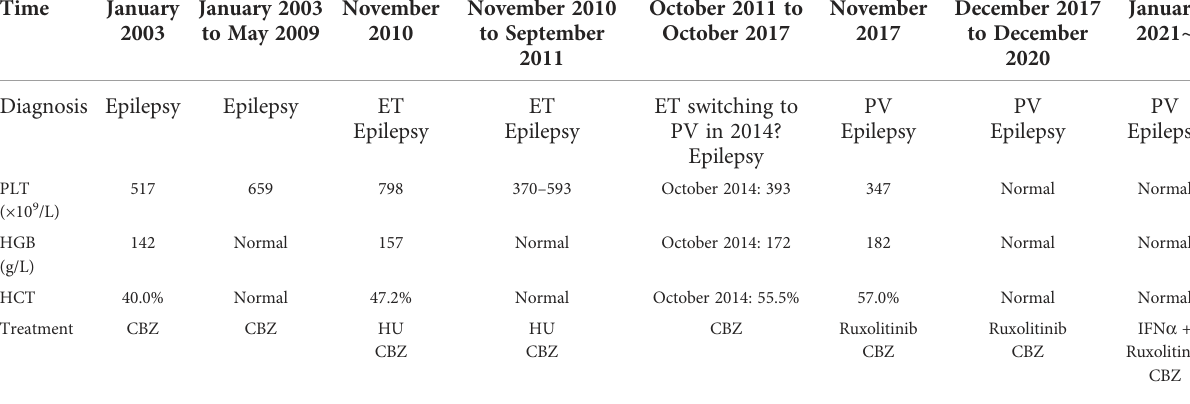
TABLE 1 Clinical and biological characteristics of this patient with the double L611S/V617L JAK2 mutation. Time